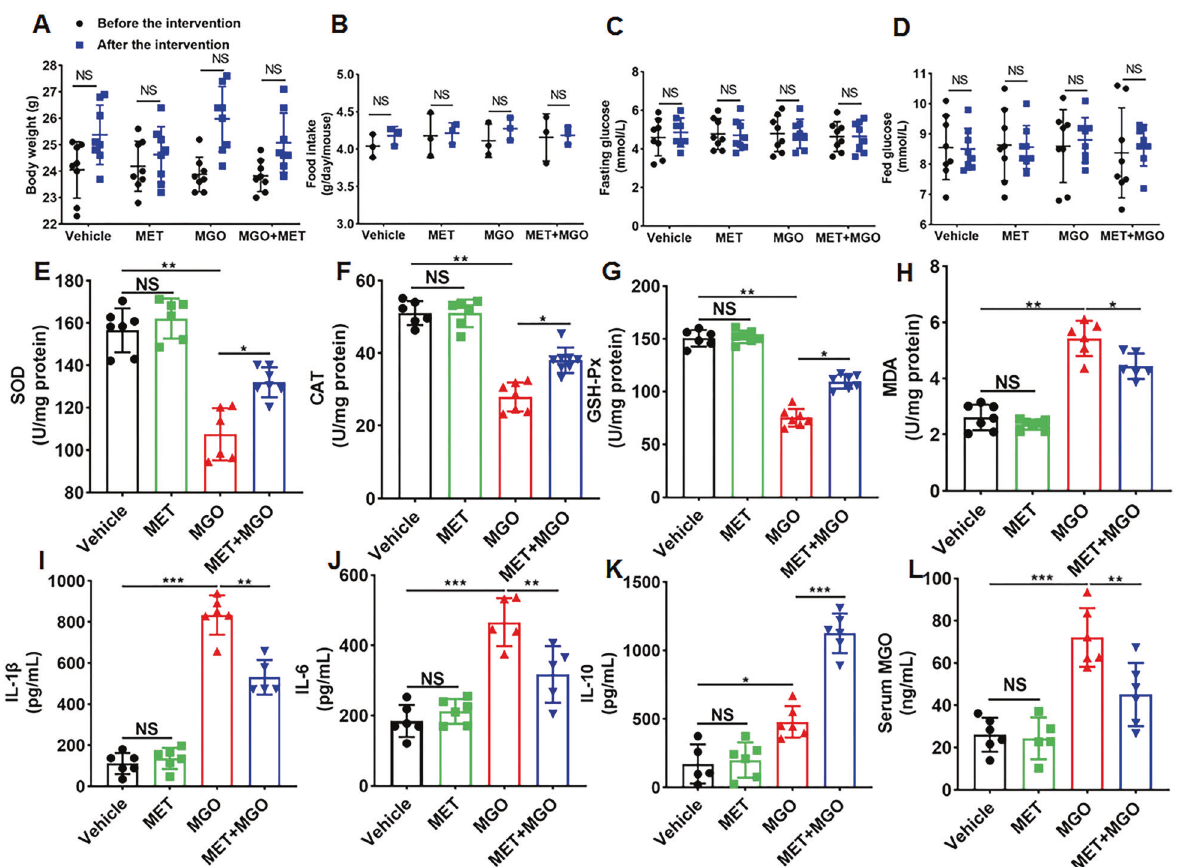
Fig. 5 Effects of MET on MGO-treated mice. C57BL/6 mice were treated with MGO and MET, and physiological and biochemical characteristics were collected regularly and analyzed. At the end of the experiment, blood samples from the mice were collected for analysis. A Bodyweight. B Food intake. C Fasting blood glucose. D Fed glucose. E – G The levels of SOD, CAT, and GSH-Px were measured with the respective kits according to the manufacturer ’ s instructions. H The MDA content was also measured. I – K Changes in the pro-in fl ammatory cytokines IL-1 β and IL-6 and the anti-in fl ammatory cytokine IL-10 were determined. L The MGO ELISA Kit was used to detect the MGO level in the serum. Data are presented as the mean ± SD, n ≥ 5 for each group. * p < 0.05, ** p < 0.01, *** p < 0.001, NS: not signi fi